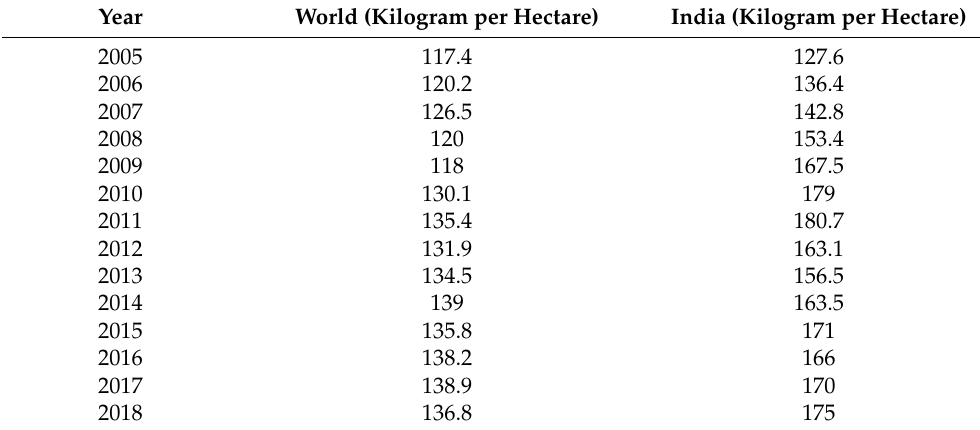
Table 1. Pesticides’ consumption across the World and India in Kilogram per Hectare of arable land according to the World Bank’s Sustainable Energy for All (SE4All) database fertilizer